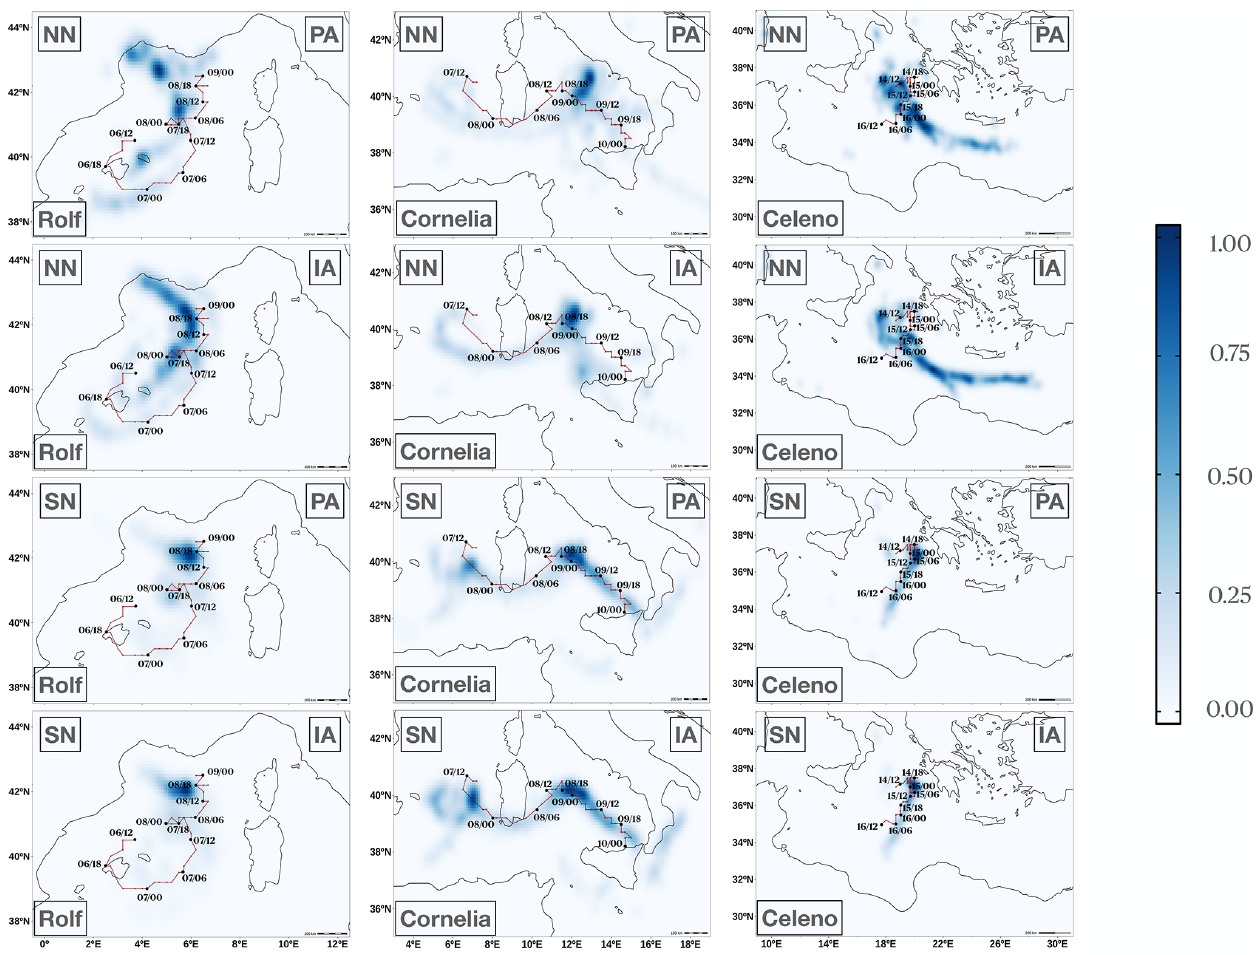
Figure 2. Normalized KDEs built on top of the medicane positions along the tracks belonging to the nudging-aerosol ensembles for medi- canes Rolf (left), Cornelia (center) and Celeno (right). In red, the track of each medicane as a result of running the TITAM (Pravia-Sarabia et al., 2020a) tracking algorithm on ERA5 hourly reanalysis data is superimposed for the time steps in which a medicane is found by the algorithm. Labels (in day/hour format) and black points are placed every 6h for the sake of